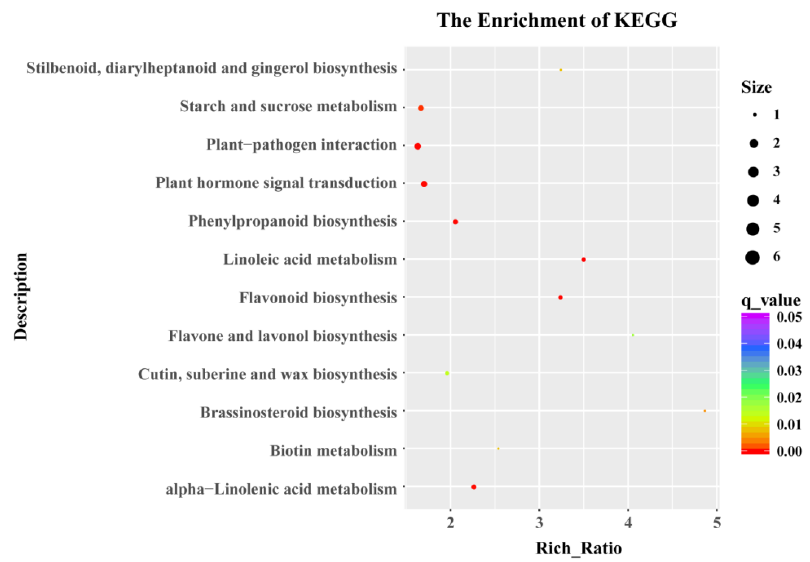
Figure 5. Scatterplot of the significantly enriched KEGG pathway in YF vs. RF.